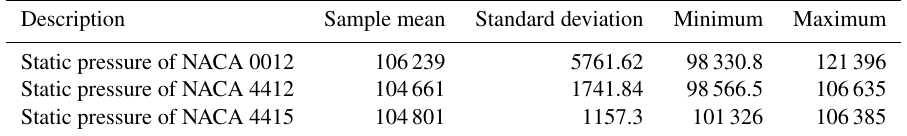
Table 3. List of data variables for static pressure.